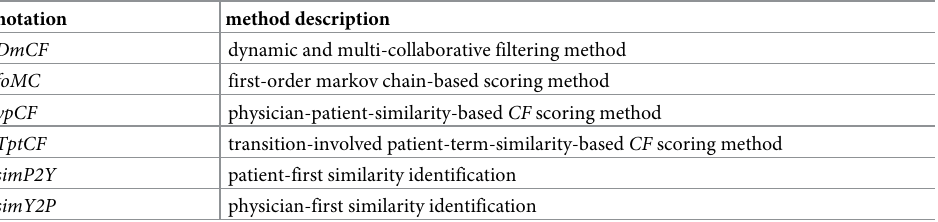
Table 2. Notations for methods used in the